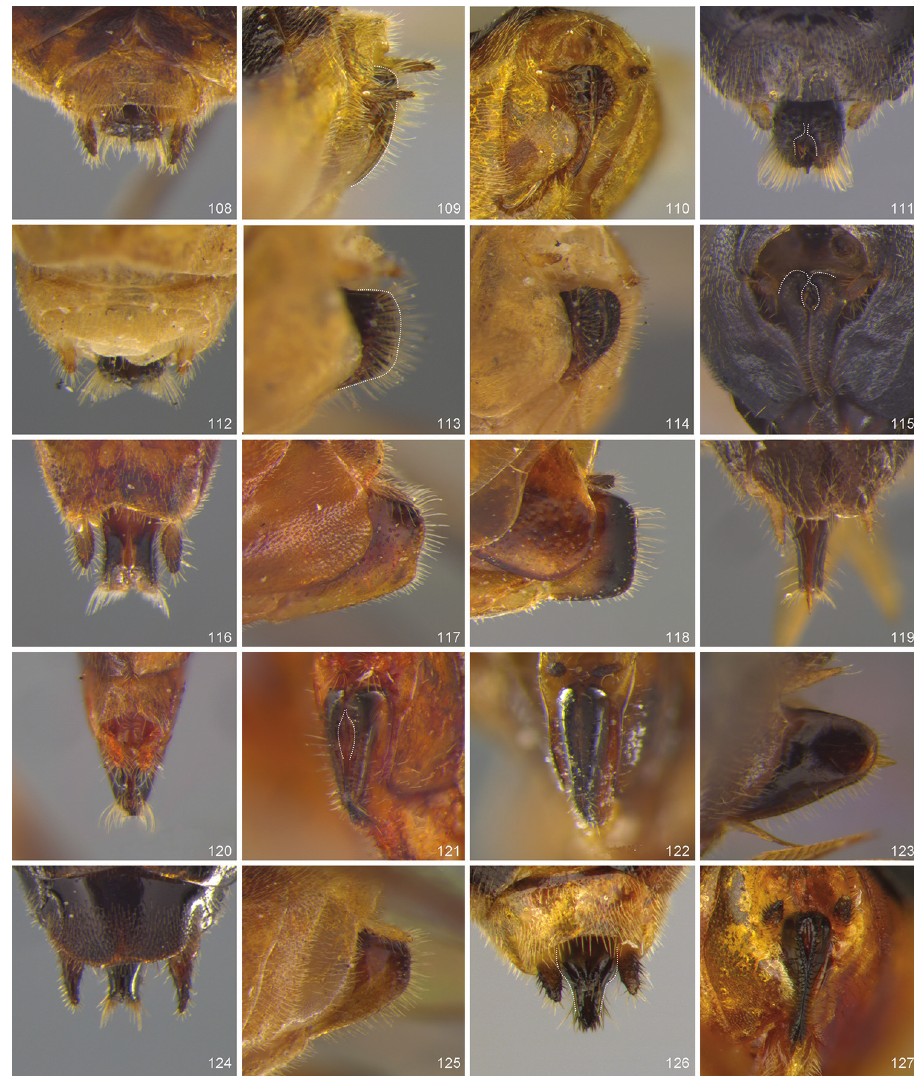
Figures 108–127. Valvula 3 of Pristiphora . 108–110 bufo DEI-GISHym17786 111, 115 nigella DEI- GISHym20972 112–114 paralella 15-255 116–117 decipiens DEI-GISHym21256 118, 122 gerula DEI-GISHym20843 119, 123 tenuiserra DEI-GISHym20846 120–121 saxesenii DEI-GISHym20844 124 erichsonii DEI-GISHym20807 125 pallida DEI-GISHym20845 126–127 glauca DEI-